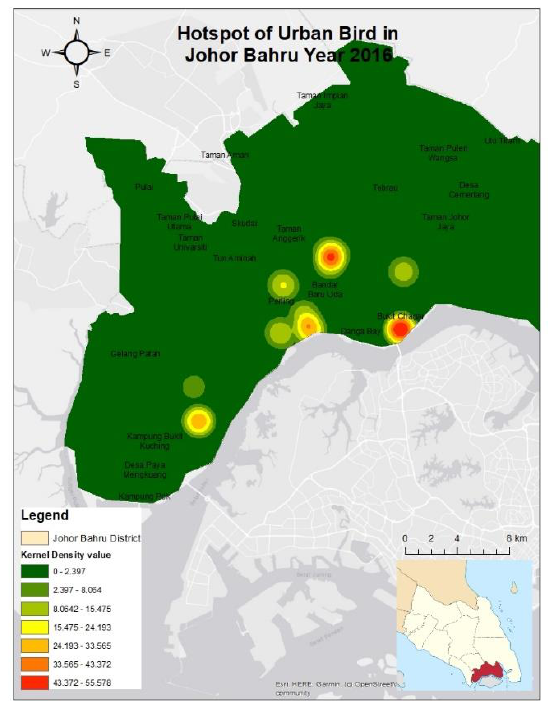
Figure 4 Urban Bird distribution for year 2016 From Figure 4 and 5, the hotspots for bird population in the year 2016 occur in Danga Bay and Kempas Denai, while in the year Taman Sentosa and Kampung Dato Sulaiman Menteri. The